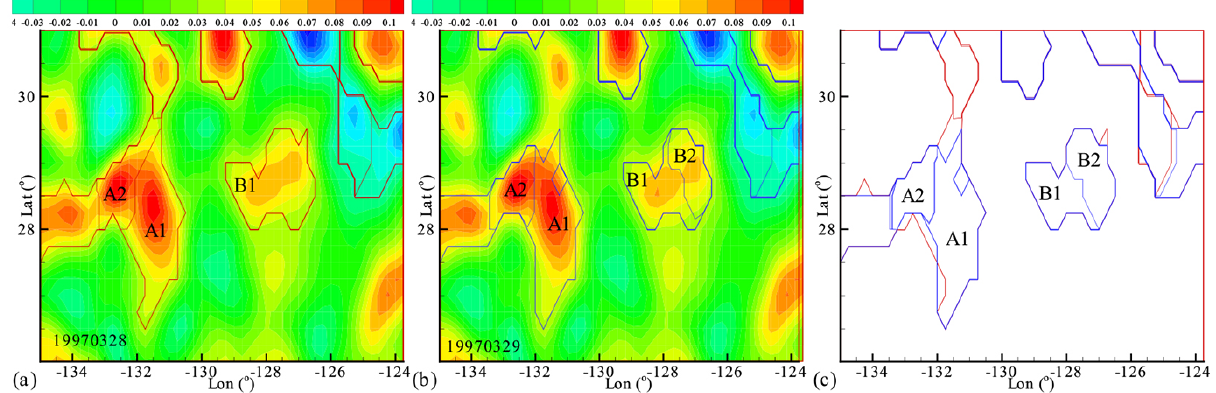
Figure 5. Sketch of eddy overlaps. (a) The SLA map (shading) and the boundary of eddies (red curves) on 28 March 1997, where A1, A2, and B1 represent identified eddies. (b) The SLA map (shading) and the boundary of eddies (blue curves) on 29 March 1997. (c) The intersection of eddy areas by overlap eddy identification maps.